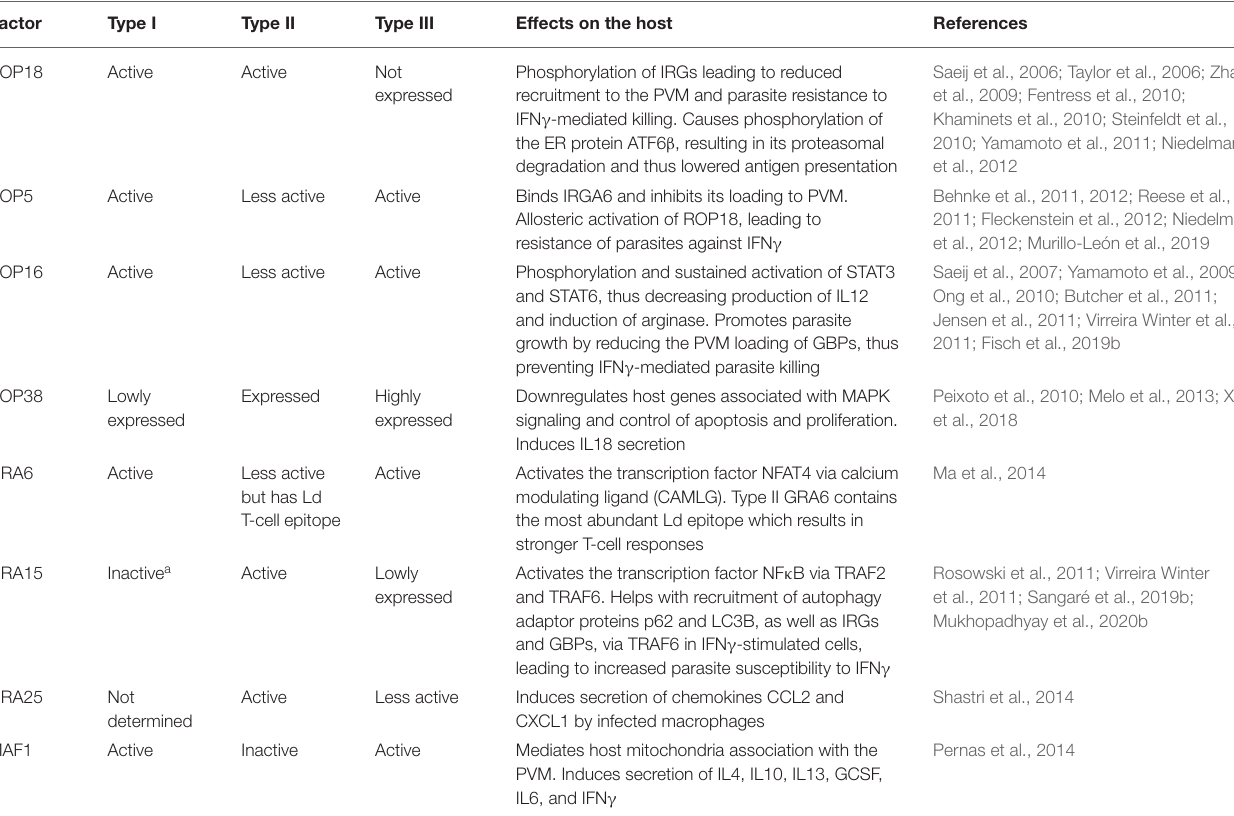
TABLE 2 | Strain-specific Toxoplasma effectors and their effects on the murine immune response.